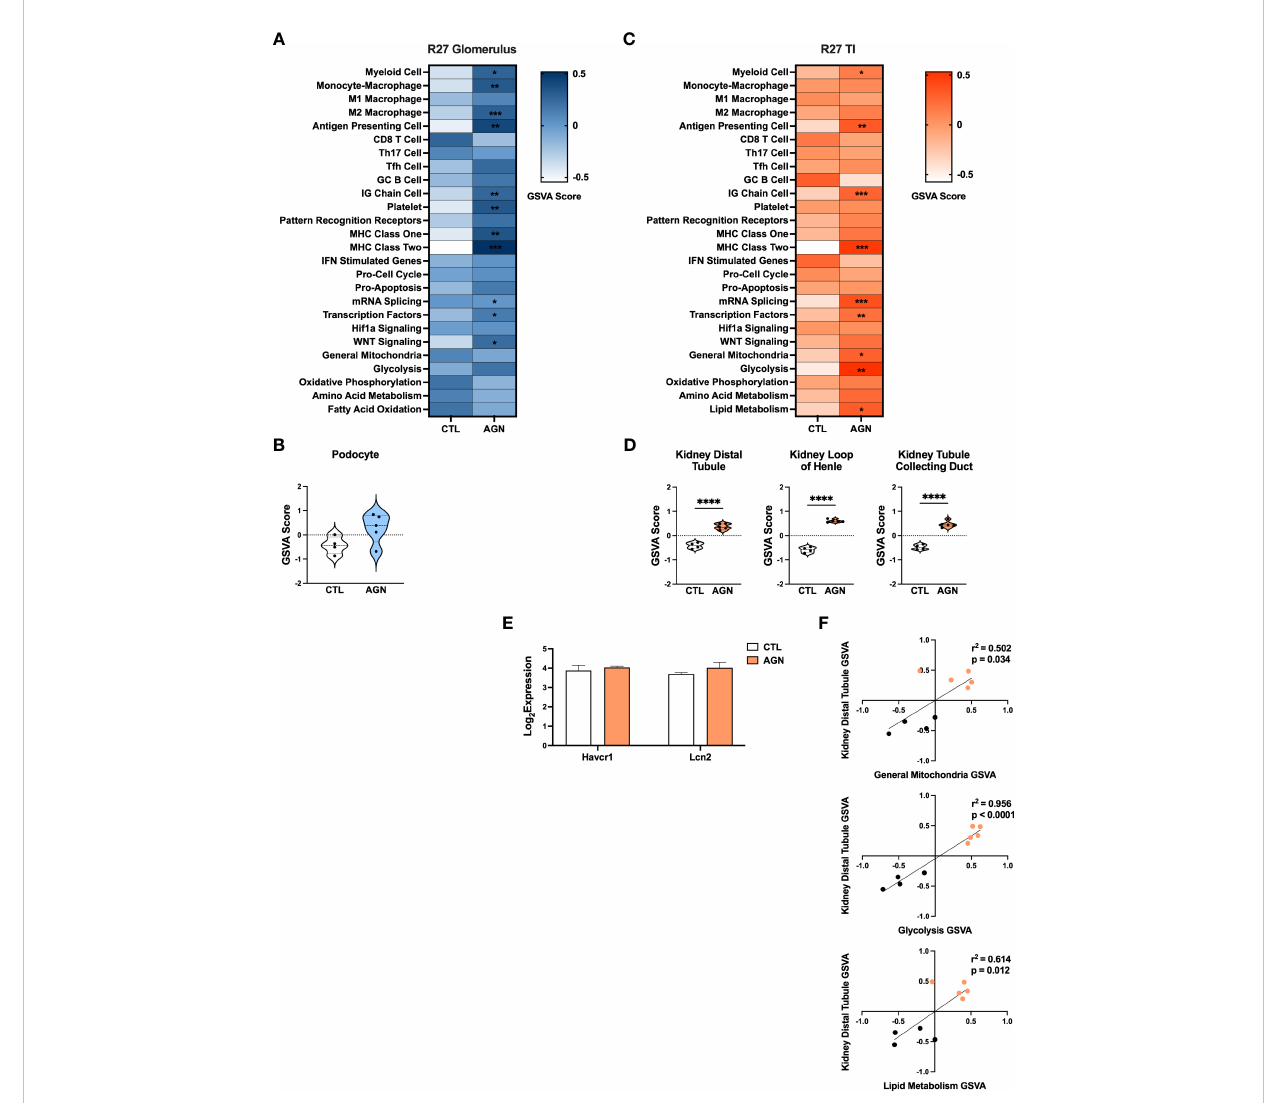
FIGURE 4 Molecular pro fi les of R27 mice differ from NZM2328 mice and indicate resistance to kidney tubule damage. (A) Heatmap of GSVA scores for enrichment of immune cell and pathway gene signatures in the glomeruli of R27 CTL and AGN mice. Asterisks indicate signi fi cant comparisons with CTL mice. (B) GSVA enrichment of podocytes in cohorts shown in A. (C) Heatmap of GSVA scores in the TI of cohorts shown in A. (D) GSVA enrichment of kidney tissue cell signatures in cohorts shown in C. (E) Log2 expression values of kidney tubule damage-associated genes for cohorts from C. (F) Linear regression between GSVA scores of kidney tubule cell and metabolic pathway gene signatures. *p < 0.05, **p < 0.01, ***p < 0.001, ****p <